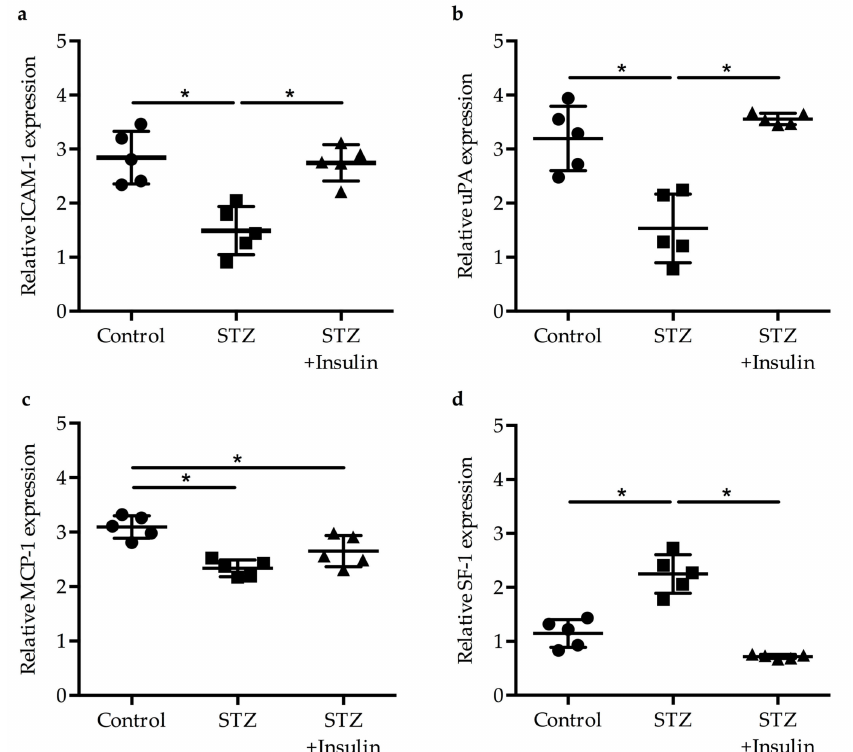
Figure 2. Gene expression of downstream targets of Egr-1 in collateral tissues obtained from mice after induction of arteriogenesis was performed by qRT-PCR ( n = 5 in each group, * p < 0.05 (each group compared to each other group) using a one-way ANOVA with Bonferroni’s multiple comparison test). The relative expression is represented as 2 ˆ − ddCT . The relative expressions of ( a ) ICAM-1 , ( b ) uPA, ( c ) MCP-1 , and ( d ) SF-1 were normalized to the expression level of the 18S